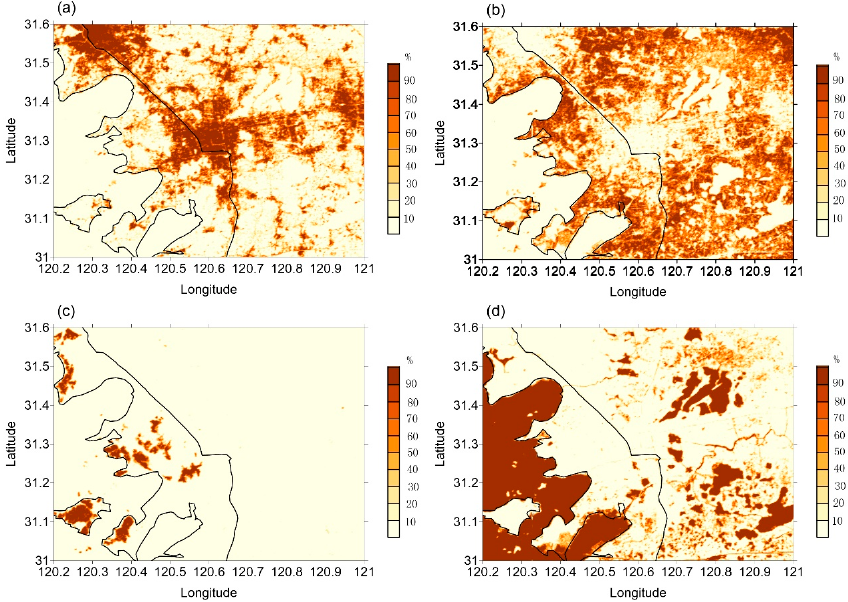
Figure 2. Simulated area and distribution of the major land use type coverage fractions: ( a ) impervious surface; ( b ) cropland; ( c ) forest; ( d ) water.